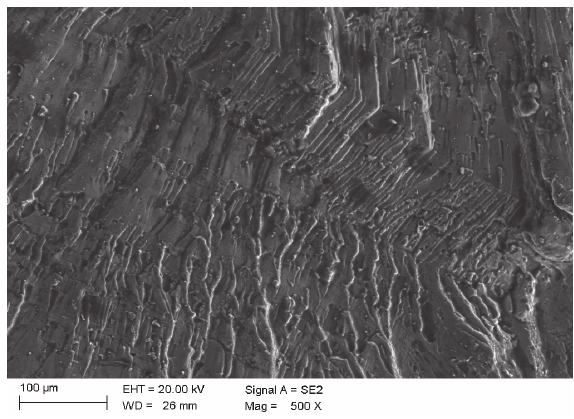
Figure 8: Transcrystalline cleavage fracture with a local initiation of brittle cracking of the intercrystalline type of the investigated alloy